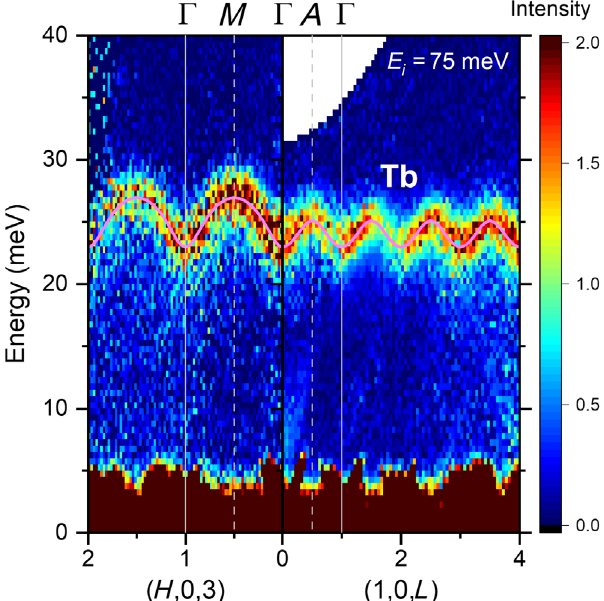
FIG. 3. (a) Slices of the neutron intensity showing the dispersion through the (0,0,2) Γ point along ð H; 0 ; 0 Þ and FIG. 4. Slices of the intensity along ð H; 0 ; 3 Þ (left) and ð 1 ; 0 ; L Þ ð 0 ; 0 ; L Þ for data taken with E ¼ 30 meV. Pink lines correspond (right) with E i ¼ 75 meV showing the intralayer and interlayer i to the model dispersion relation obtained from fits described dispersion of the Tb mode, respectively. The two slices employed below. Gray vertical lines identify Brillouin zone centers (solid) reciprocal space averaging of Δ L ¼ (cid:4) 0 . 1 and Δ H ¼ (cid:4) 0 . 1 r : l : u : , and zone boundary points (dashed), as labeled on the top axis. respectively, with Δ K ¼ (cid:4) 0 . 058 r : l : u : used in both slices. Pink (b) Energy spectrum through (0,0,2) averaged over q ranges of lines correspond to the dispersion relation obtained from fits Δ H ¼ Δ K ¼ (cid:4) 0 . 035 and Δ L ¼ 0 . 1 r : l : u : The red line is a described below. Gray vertical lines identify Brillouin zone Gaussian fit that indicates a resolution-limited peak correspond- centers (solid) and zone boundary points (dashed), as labeled ing to a spin gap of Δ ¼ 6 . 5 meV. on the top